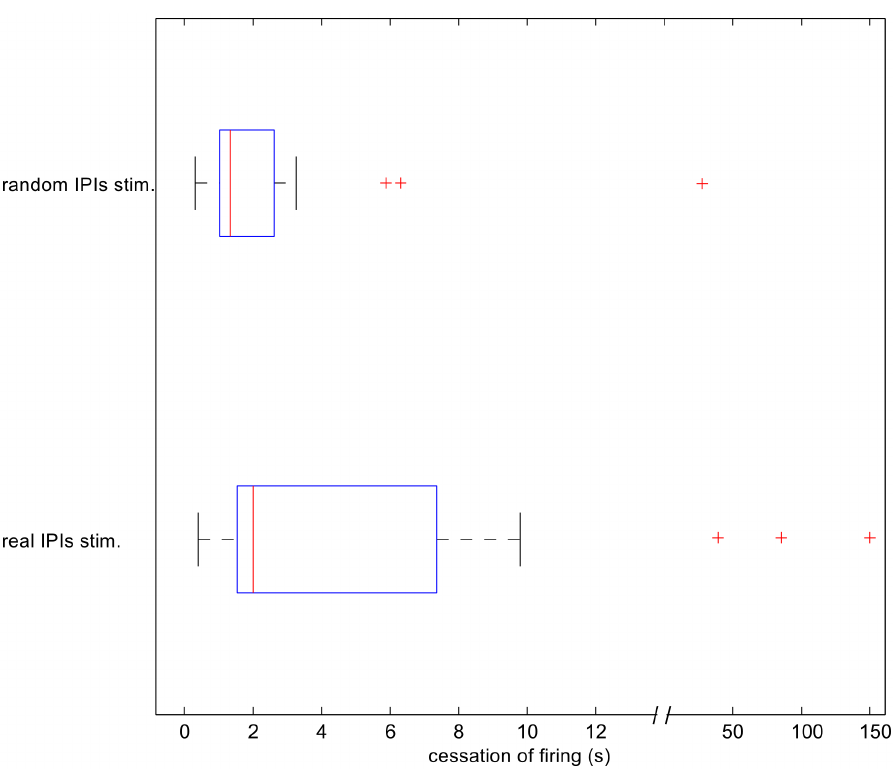
Figure 9. Cessation of fire. Fish presented longer cessation of fire during the real stimuli sessions compared to those for the random stimuli ones (Wilcoxon p , 0.05). The longest cessations of fire lasted 150 s for the real stimuli sessions and 43 s for the random stimuli ones. The medians were 2.0 s and 1.3 s for the real stimuli sessions and random stimuli sessions, respectively. Cessation of firing was defined those IPIs 2 times longer than the mean IPI.